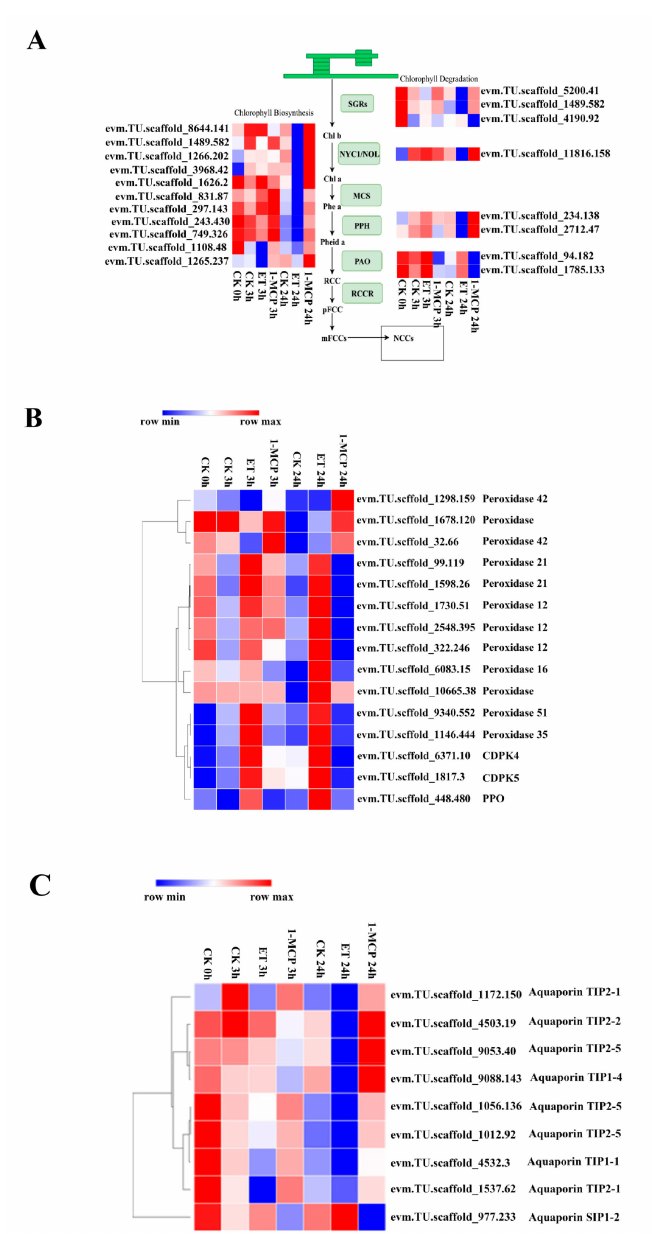
Figure 4. Heatmap analysis of DEGs involved in various processes. Chlorophyll synthesis and degradation ( A ), ROS (reactive oxygen species) ( B ), and aquaporin signaling pathway ( C ) are shown. DEGs, differentially expressed